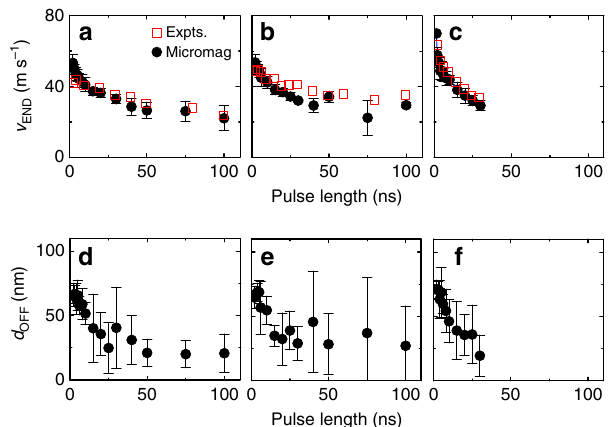
Figure 5 | Comparison of experiments and micromagnetic simulations ( a – c ) Quasi-static domain wall (DW) velocity v END (red squares) measured as a function of pulse length for three different pulse amplitudes: ( a ) 16V ( J B 0.5 (cid:3) 10 8 Acm (cid:2) 2 ) ( b ) 20V ( J B 0.6 (cid:3) 10 8 Acm (cid:2) 2 ) and ( c ) 25V ( J B 0.8 (cid:3) 10 8 Acm (cid:2) 2 ). All results are from film set B, wire width is B 5 m m and the W layer thickness d is B 3nm. The black circles show calculated v END using micromagnetic simulations with two dimensional pinning. The average velocity is obtained from 5 different randomly generated grain patterns. ( d – f ) Average distance DWs travel after the current pulse is turned off ( d OFF ) calculated using micromagnetic simulations. The error bars indicate distribution due to different grain patterns used in the